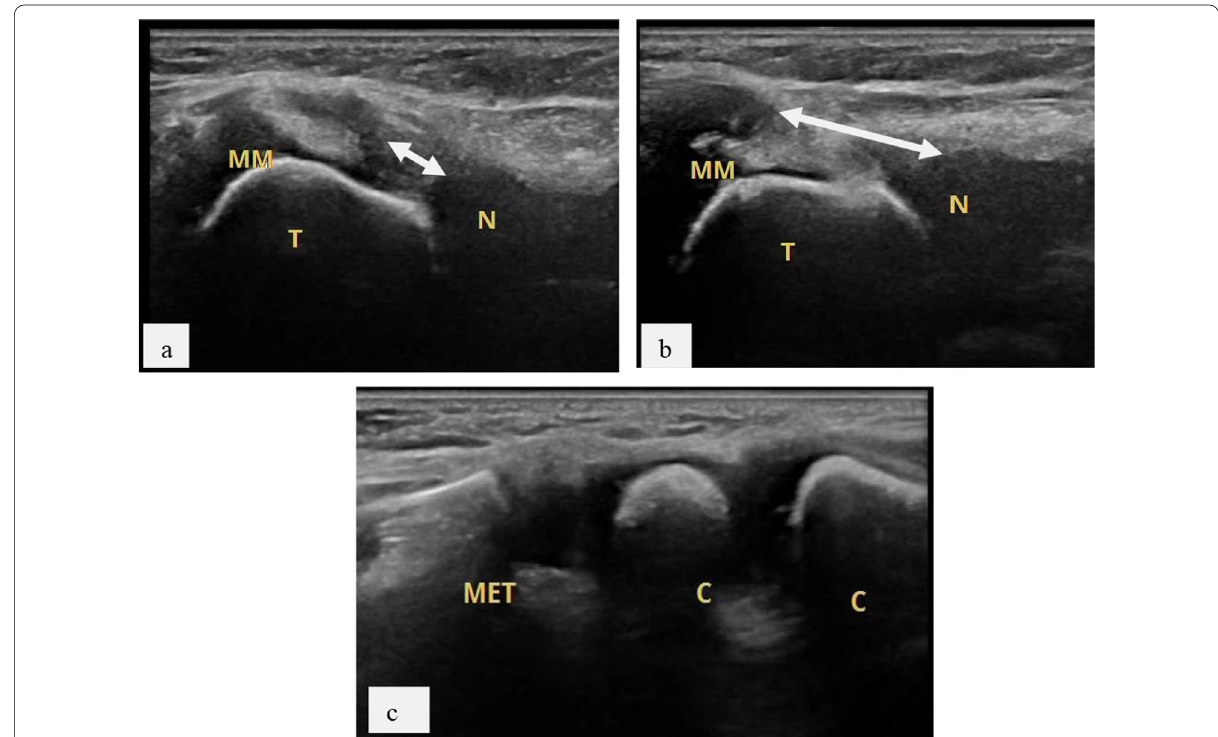
Fig. 7 Ultrasound scan dorsal sagittal view of left foot of another 12-day-male baby, presenting with club foot, showing a decreased MMN distance in dorsiflexion than neutral position. b Increased MMN distance in planter flexion. c Lateral coronal view of left foot showing angulation of the lateral column. (Met Metatarsal bone, C cuboid, C calcaneus, = = =